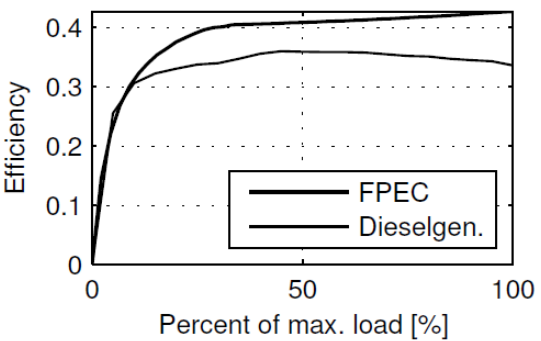
Figure 1. Efficiency from fuel to electrical power to the DC-link for an FPEG and a typical diesel- generator [1,2]. This figure has been reproduced with permission from IEEE ©2006 IEEE.